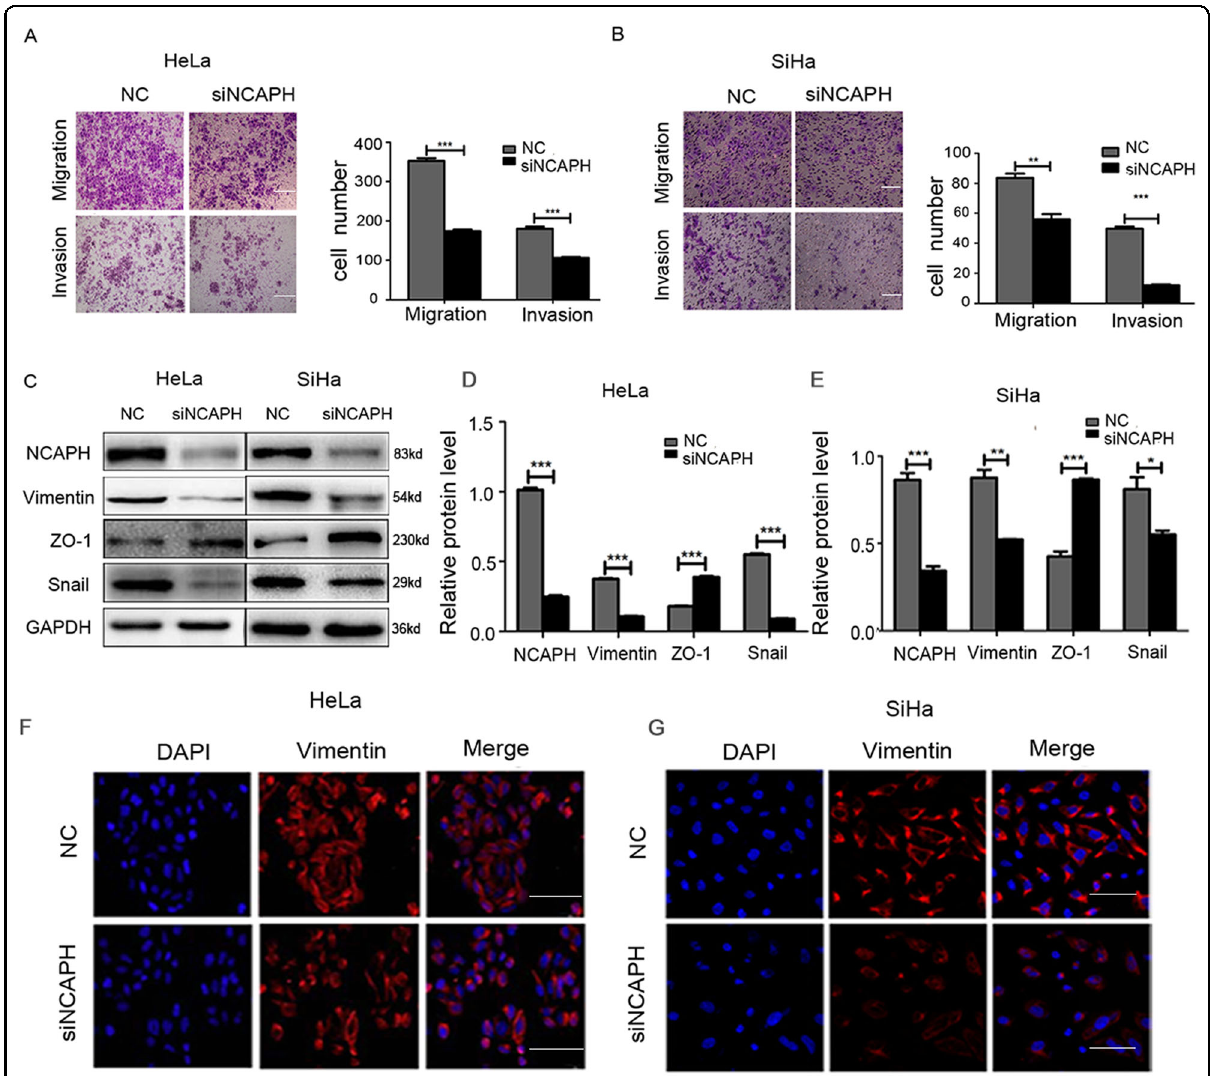
cells treated with negative control siRNA; siNCAPH, cells treated with siRNA targeting NCAPH gene. Scale bars, 100 μ m. Results shown are representative of triplicate experiments. Data are presented as mean ± SD ( n = 3). * represents p < 0.05, ** represents p < 0.01, *** represents p <